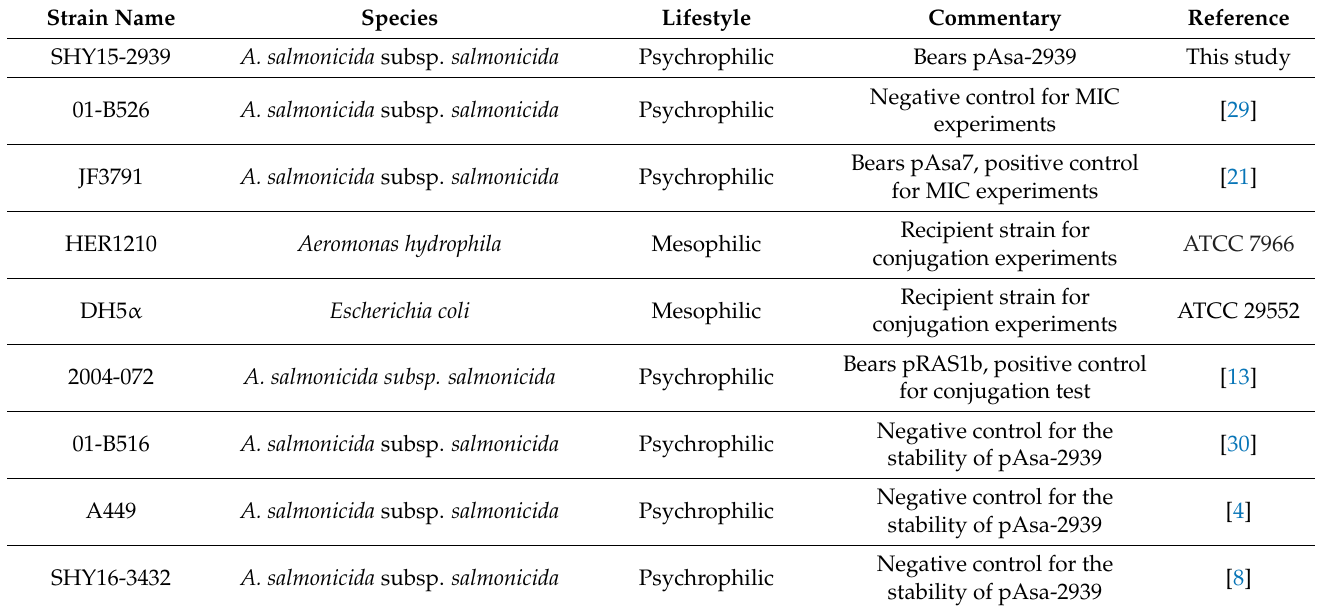
Table 1. Strains used in this study.